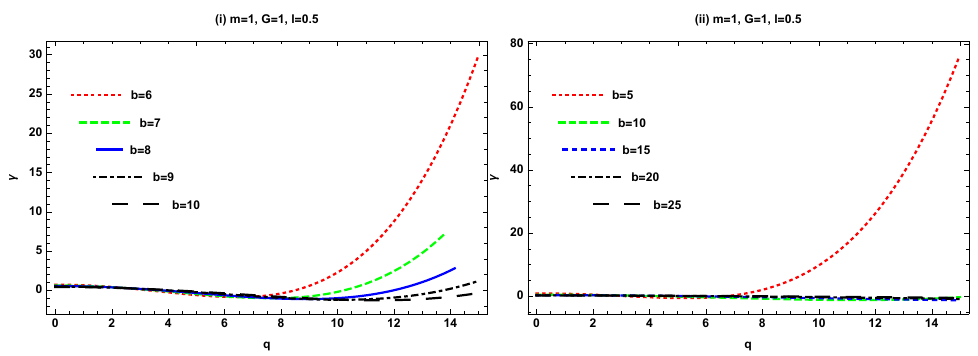
Figure 2: γ in connection with q .